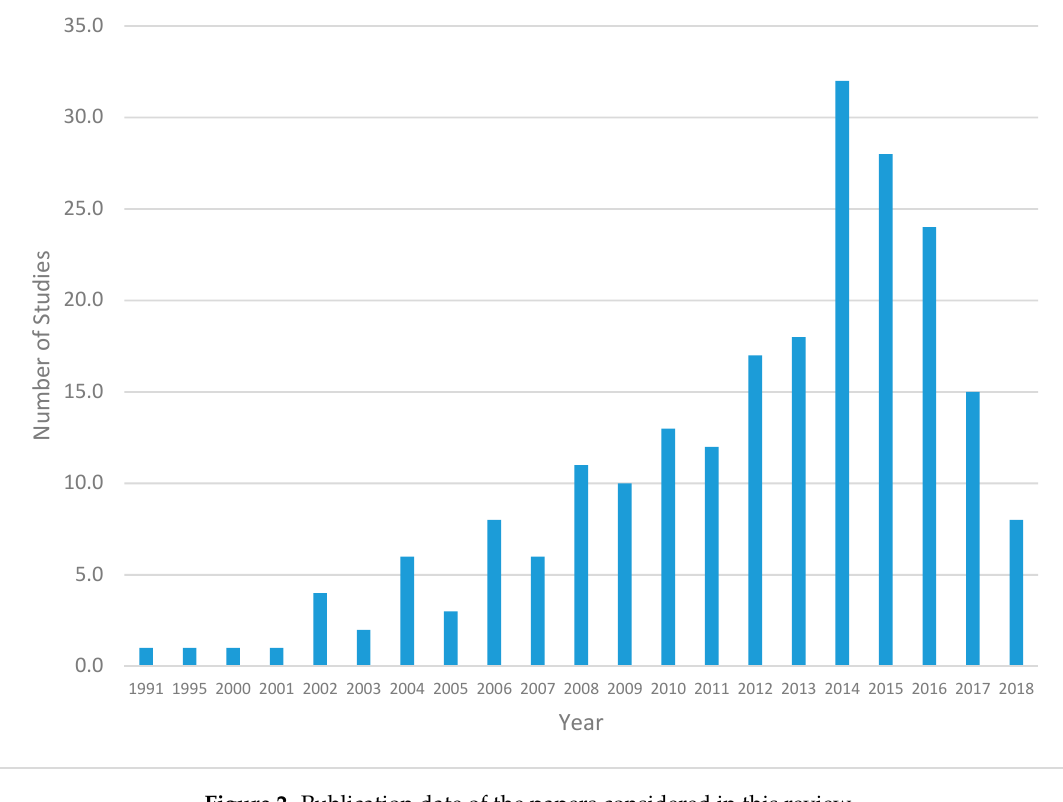
Figure 2. Publication date of the papers considered in this review. Int. J. Environ. Res. Public Health 2020 , 17 , x